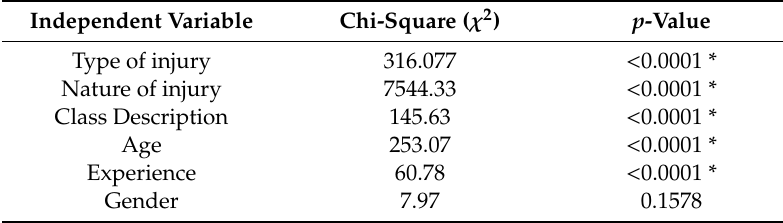
Table 1. Variable importance using chi-square test.